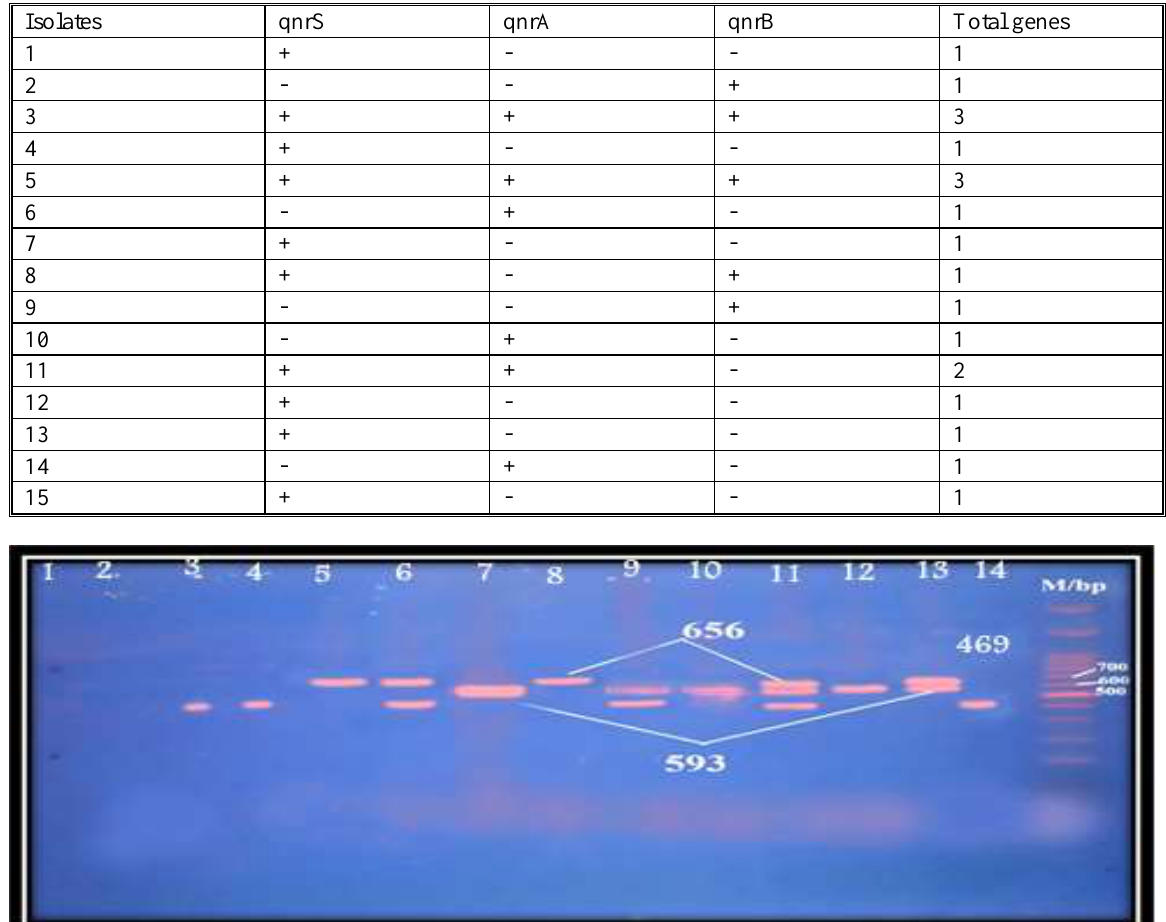
Table 2. Distribution of qnr genes through Salmonella enterica serotype Typhi isolates Ciprofloxacin resistance .